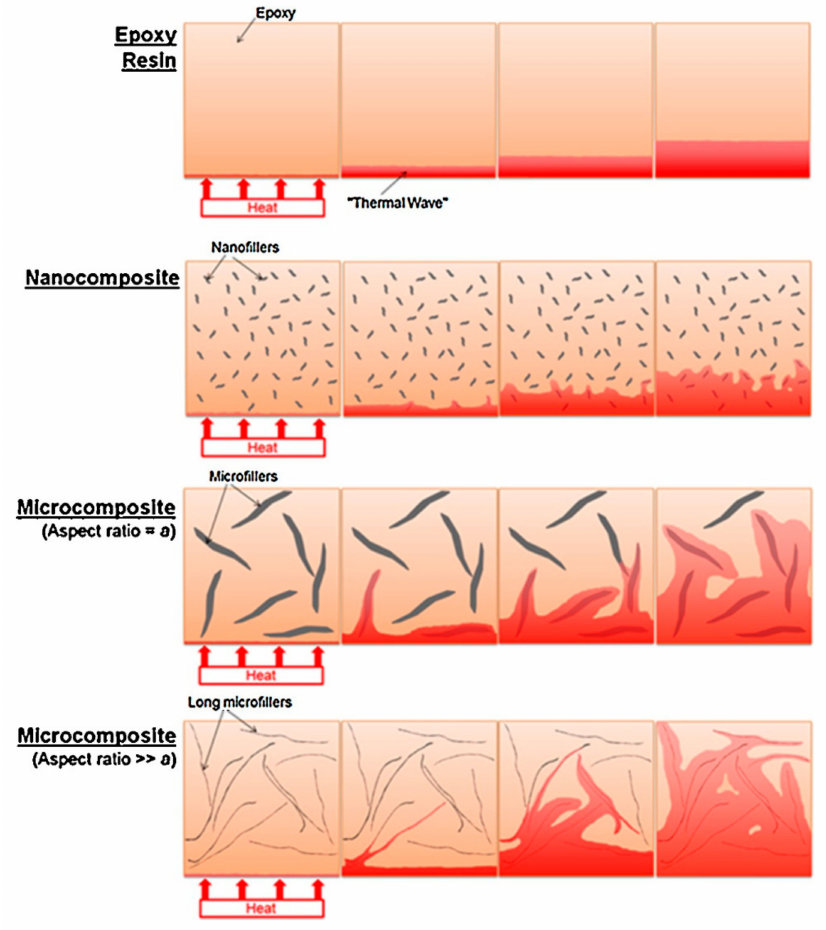
Figure 2. Schematic diagram illustrating the thermal conduction mechanism depending on size and aspect ratios in the composites. Reprinted with permission from [40]. Copyright 2016 Elsevier